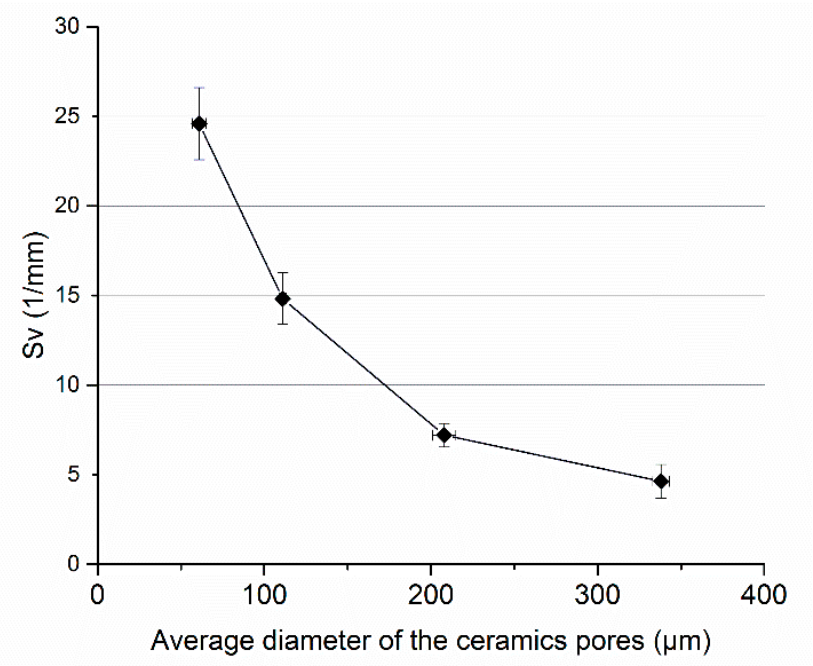
Figure 8. The specific surface fraction S v of the interphase boundaries of composites depending on the pore size of the ceramic preform.